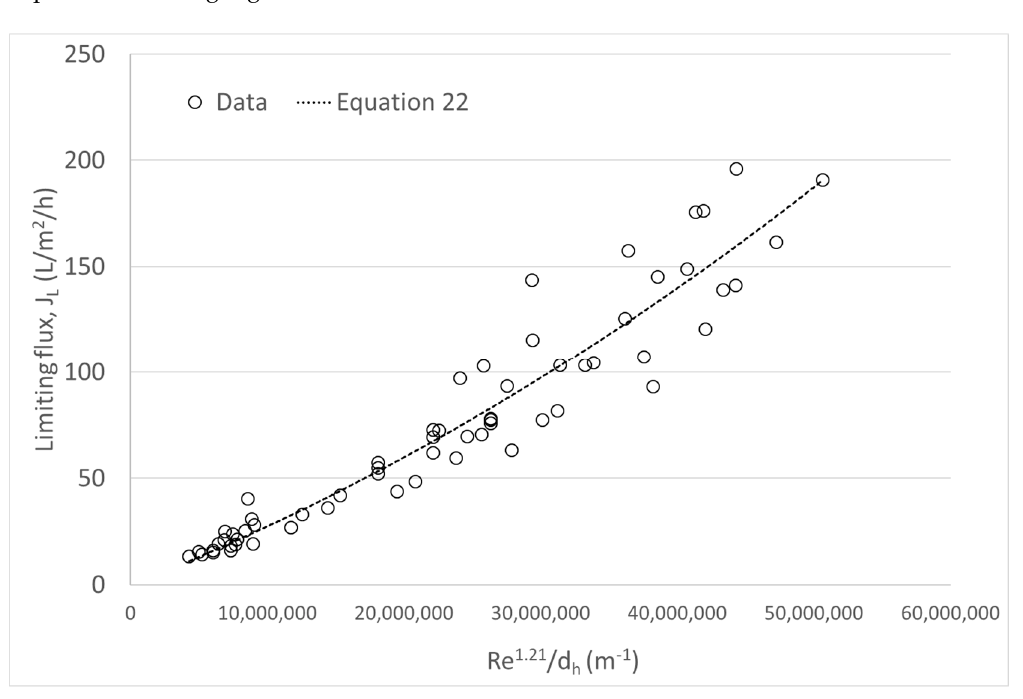
Figure 7. J L versus Re b / d h curve during skim milk microfiltration using data from three hydraulic diameters: 2, 3.6, and 6 mm ( n = 62), where b was fixed at 1.21.